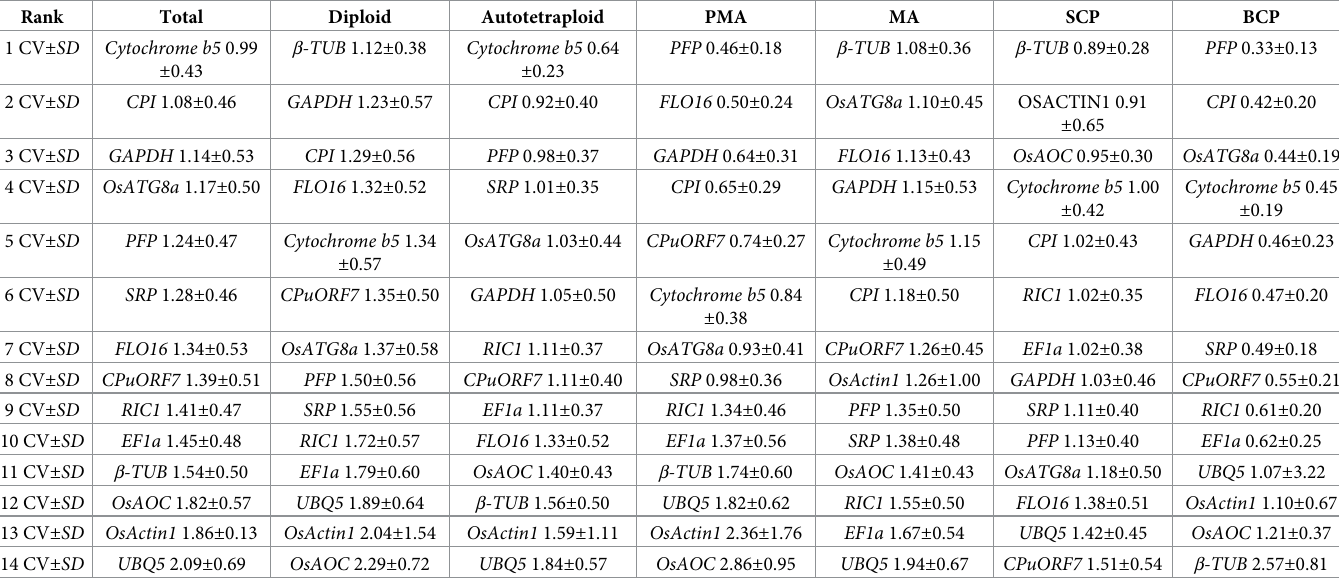
Table 4. Stability analysis of candidate reference genes assayed by BestKeeper software.